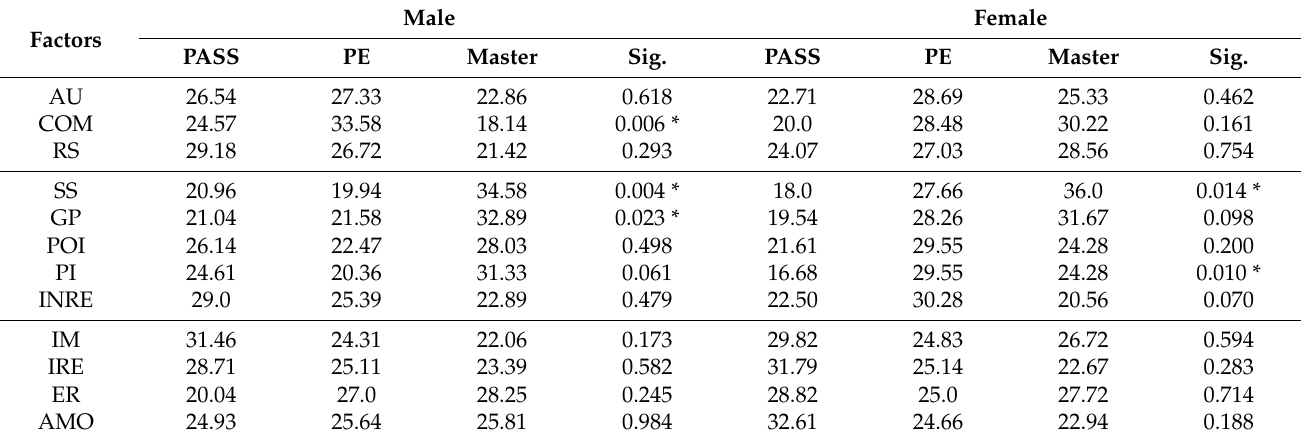
Table 4. Kruskal–Wallis significant ranges and significant difference: degree and gender.